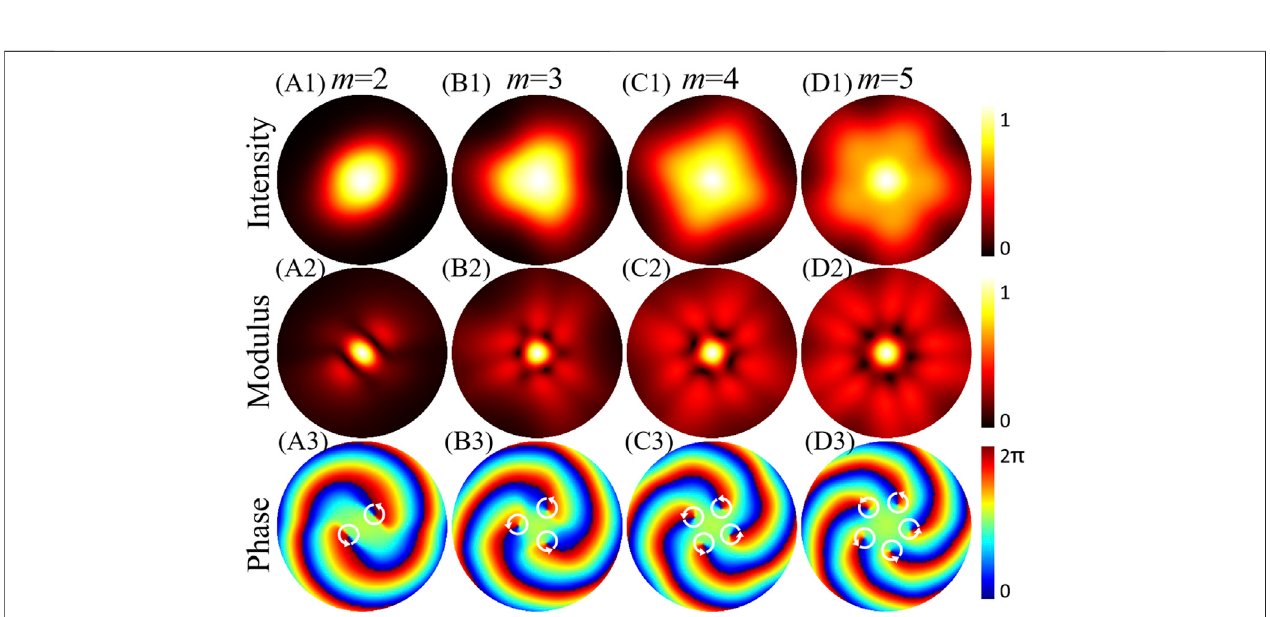
FIGURE 6 | Numerical simulation intensities and CSD distributions of the PC-PEPV beams on the focal plane with low spatial coherence ( σ (cid:1) 0.5 mm) and power order n (cid:1) 2. (A1 – D1) are the intensity patterns, (A2 – D2) are the modulus of the CSD function, and (A3 – D3) are the phase patterns of the CSD function. White circular arrows represent the anticlockwise direction of the phase winding which indicates the positive